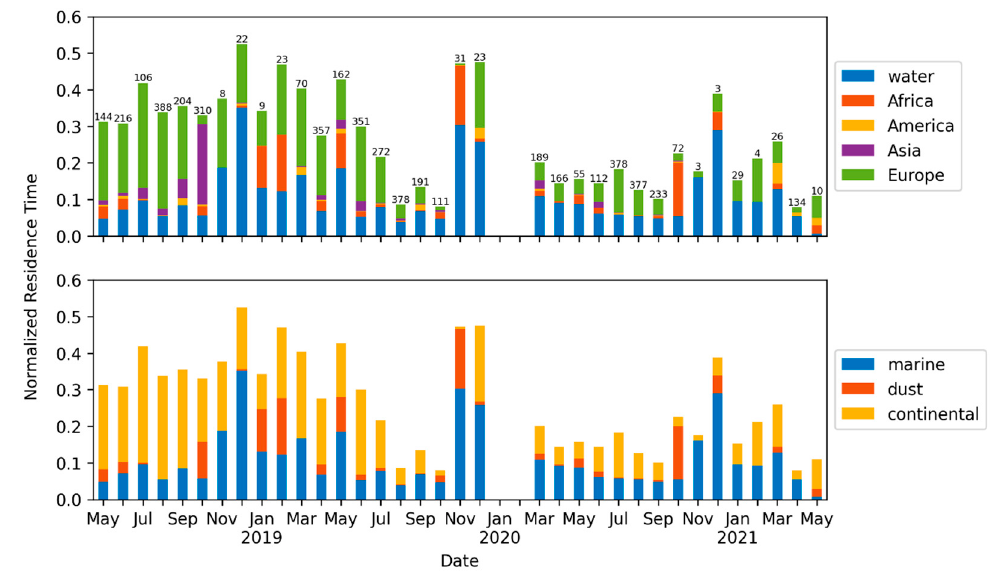
Figure 6. Normalized residence time over continents ( upper plot ) and the associated aerosol type ( lower plot ). The numbers on top of the bars represent the number of cases for each month. Water stands for sea and/or ocean.